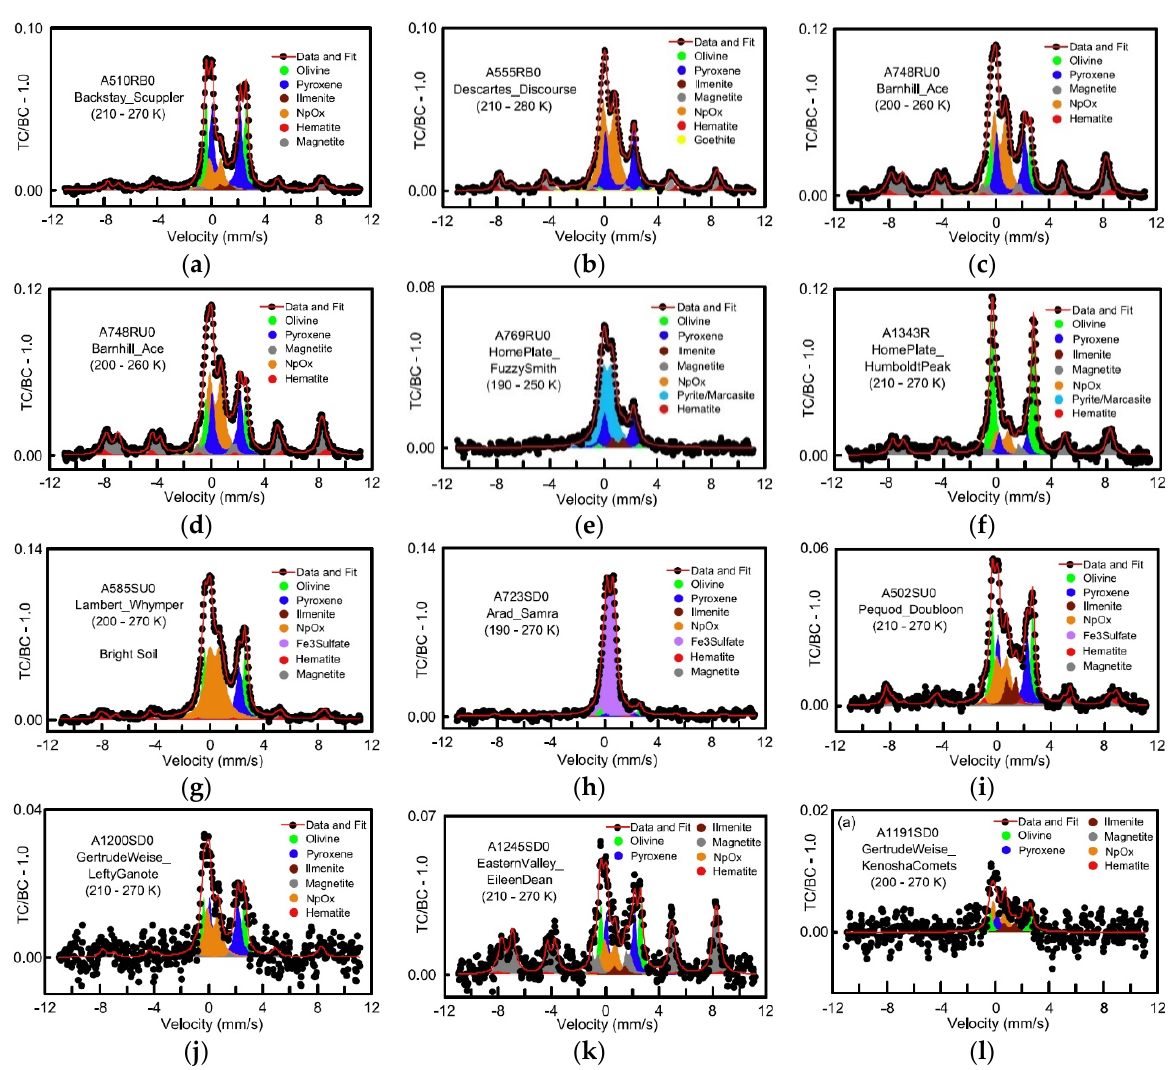
Figure 49. Selected Mössbauer spectra of Mars rocks ( a – c ), outcrop rock ( d ), float rocks ( e , f ), and soils ( g – l ) measured by Spirit rover at the Gusev Crater. NpOx means nanophase ferric oxide, Fe3Sulfate means Fe 3+ -bearing sulfate. Adapted from [143].